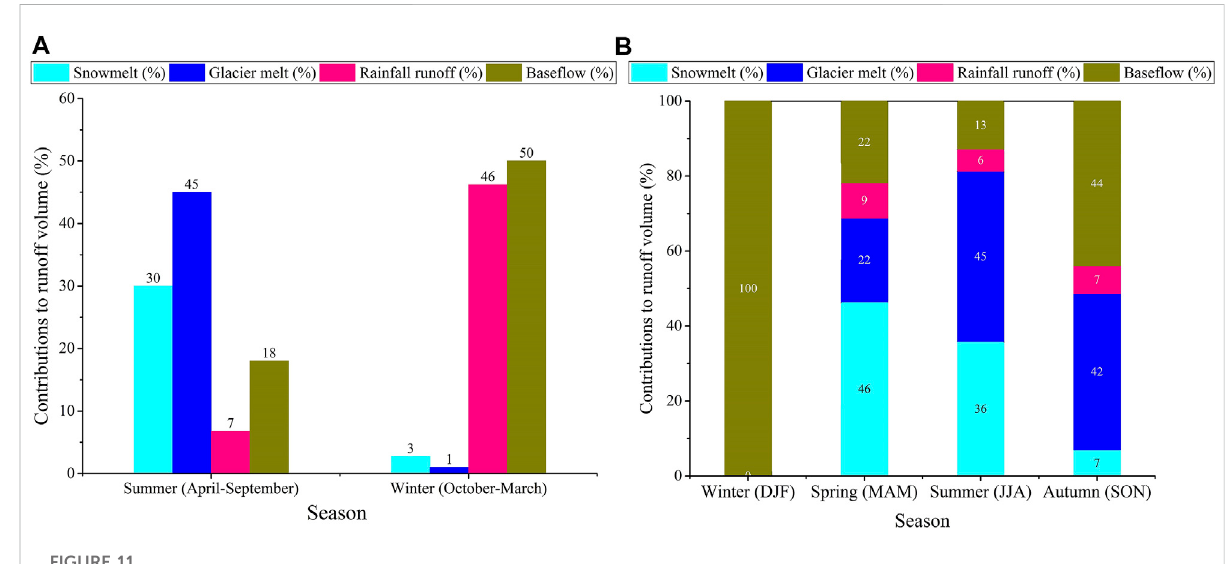
FIGURE 11 Relative contribution of runoff components to stream fl ows in different seasons.